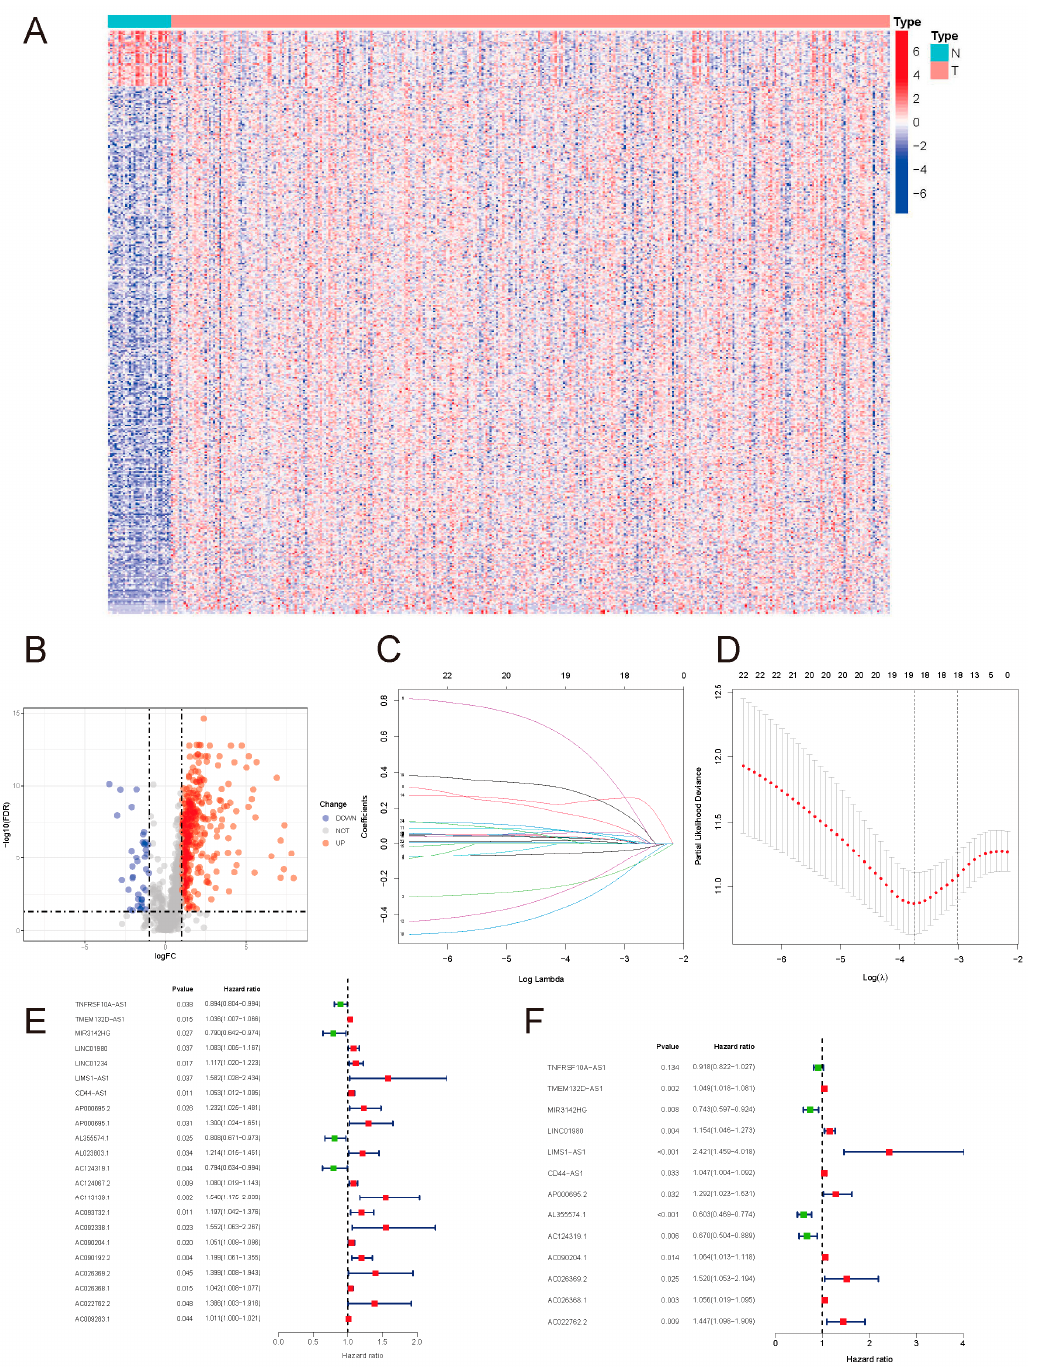
Figure 2. ( A ) DEirlncRNA heatmap. ( B ) DEirlncRNA volcano map. A total of 414 DEirlncRNAs were identified, including 375 upregulated and 39 downregulated ones. ( C ) Coefficients of the LASSO regression. ( D ) Partial-likelihood deviances of the LASSO model. ( E ) Prognostic DEirlncRNA forest map. ( F ) Forest map of lncRNAs included in the